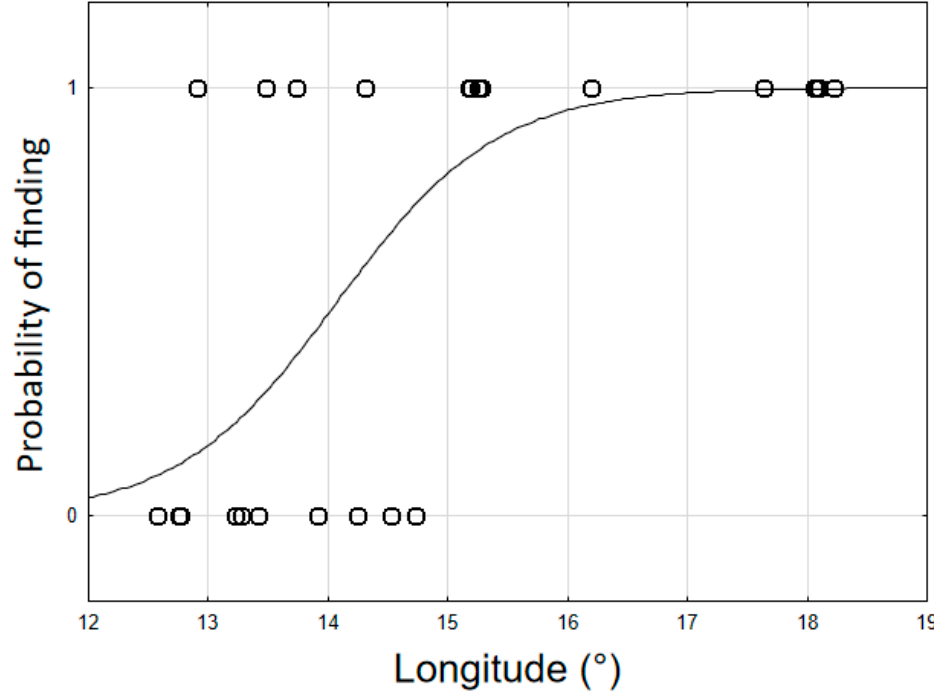
Figure 3. Logistic model for the probability of detecting Phloeosinus aubei in the Czech Republic as related to longitude. On the y -axis, 0 and 1 indicate that P. aubei was not detected or was detected, respectively.